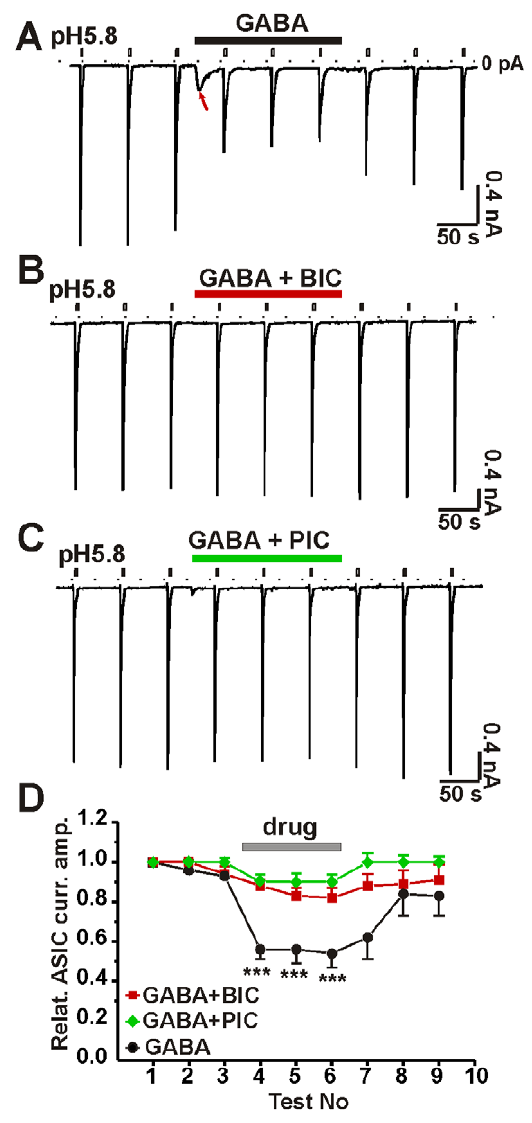
Figure 1. Activation of GABA A receptors reversibly inhibits ASIC currents. A, ASICs were activated by pH 5.8 solution repetitively in every minute. GABA (100 m M) reversibly attenuated ASIC currents. Red arrow indicates the current activated by GABA. Persistent application of GABA desensitized a large portion of GABA A receptors and steady-state GABA-current was small compared to ASIC currents (Figure S1). Dashed line indicates a position of zero current. B and C, co-application of bicuculline (BIC, 100 m M, B) or of picrotoxin (PIC, 100 m M, C) with GABA blocked GABA-activated current and abolished the inhibition of ASICs. D, statistic graph shows relative ASIC currents that were affected by GABA but reversed by antagonists of GABA A receptors. n=6–8, ***, p , 0.001, T-test, GABA plus GABA antagonists vs. GABA